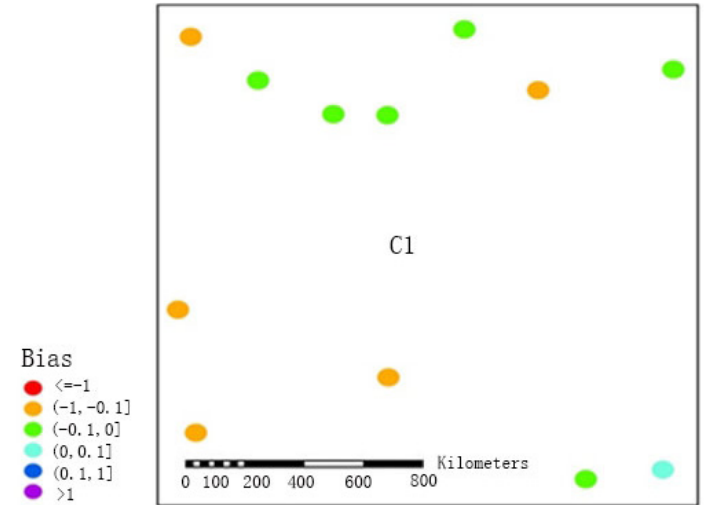
Figure 8. Spatial distribution map of biases in region C1 with FMP between May and September from 2005 to 2010.